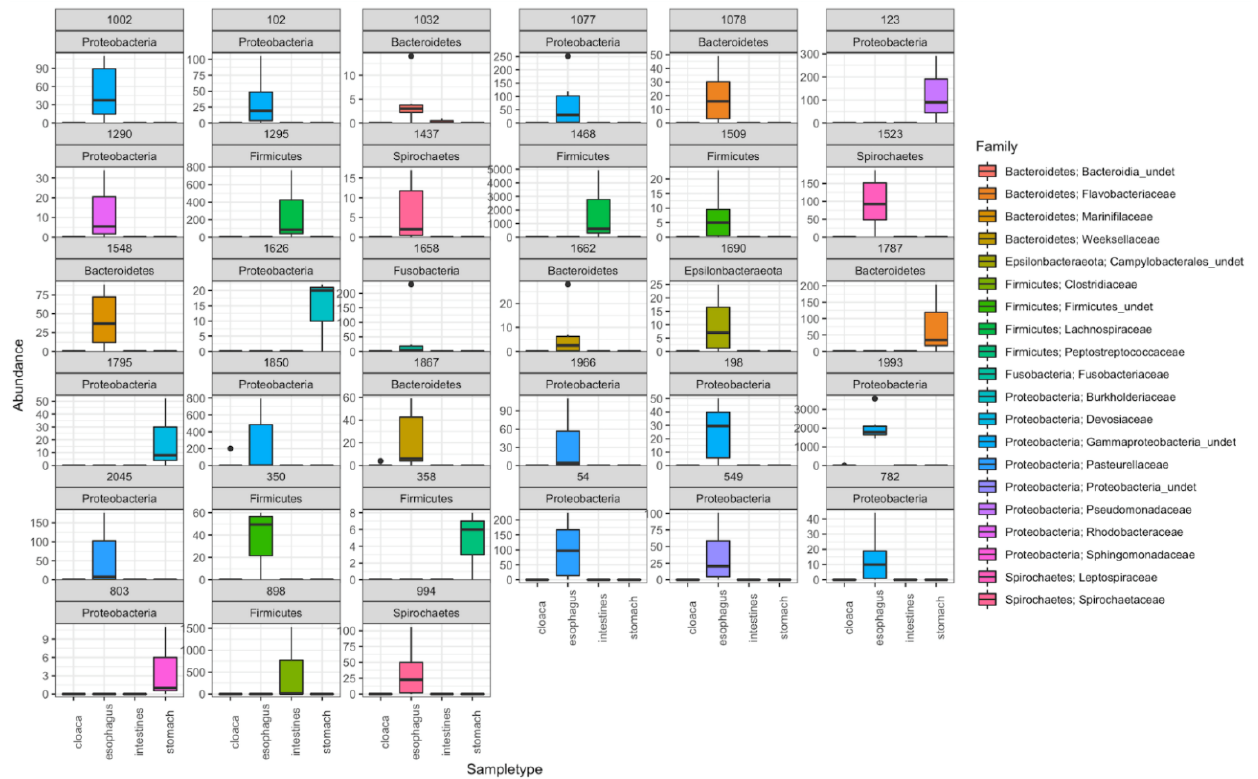
Figure 4. Indicator species analysis for green turtle gastro-intestinal (GI) compartments and for green turtle putative food item groups (seagrass and macroalgae species). The number of indicator ASVs and phylum affiliations appear at the top of each box plot. The corresponding family of each indicator ASV is listed in the legend. Each boxplot corresponds to one indicator and the compartment it appears on is labelled in the X axis. Abundance of the indicator in the expressed sample type is shown in the Y axis.